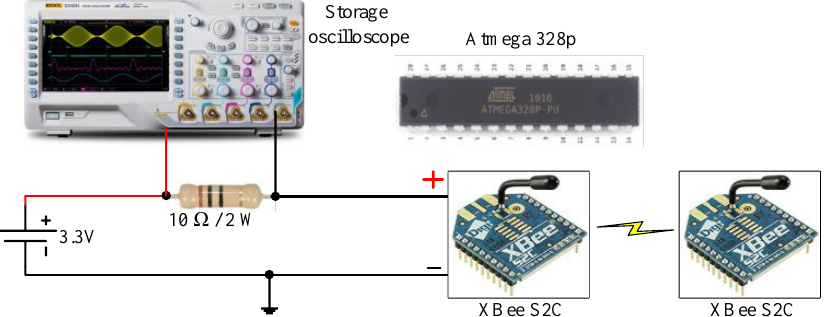
Figure 9. Test bed current consumption measurements of Atmega 328p and XBee S2C.